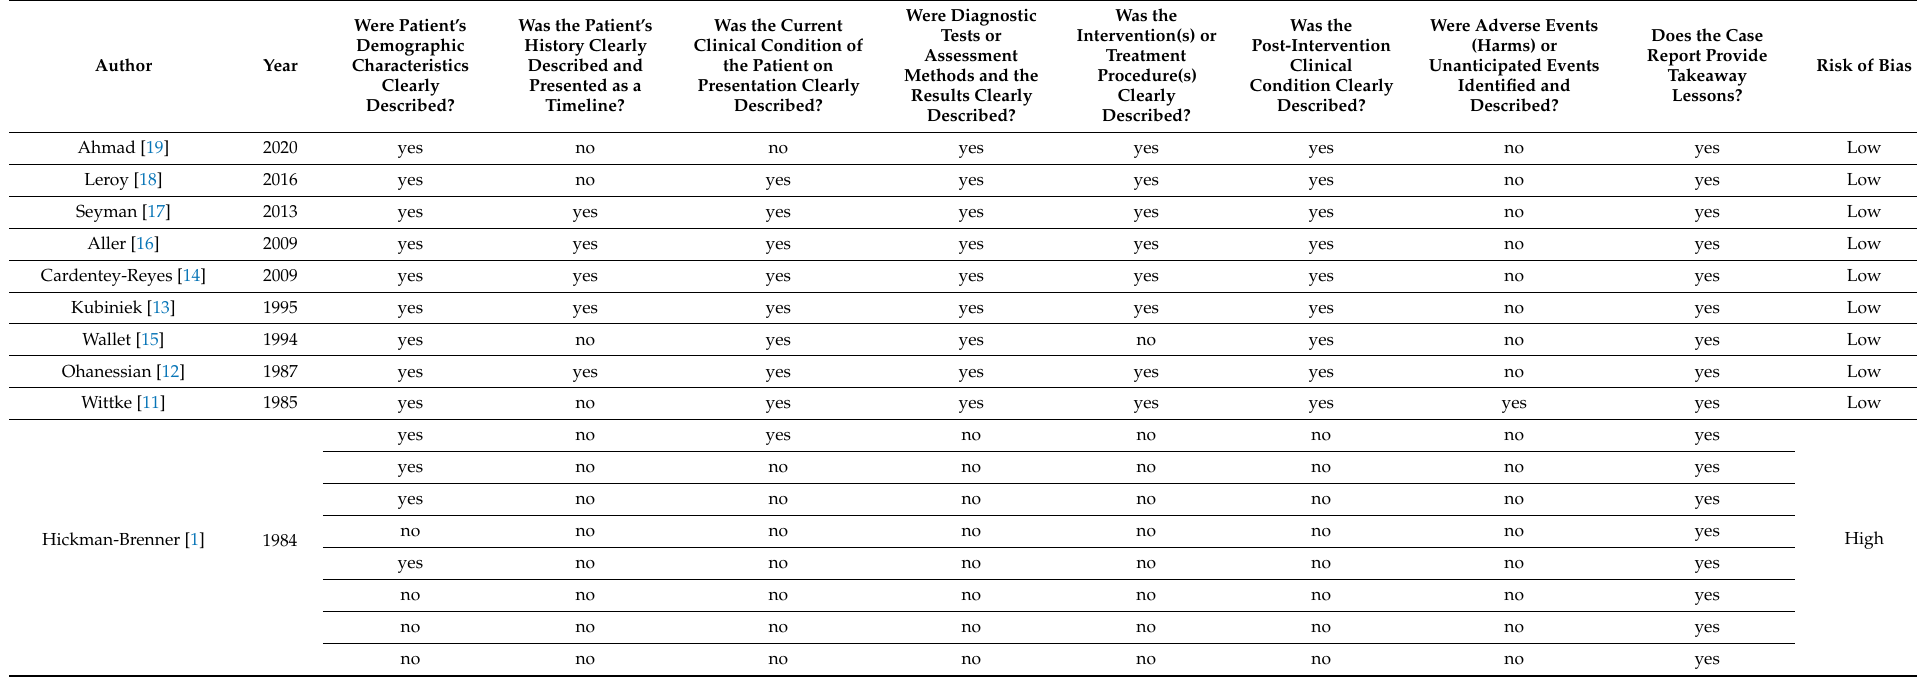
Table 2. Reported cases and their risk of bias according to the Joanna Briggs Institute (JBI) Critical Appraisal Checklist for Case Reports